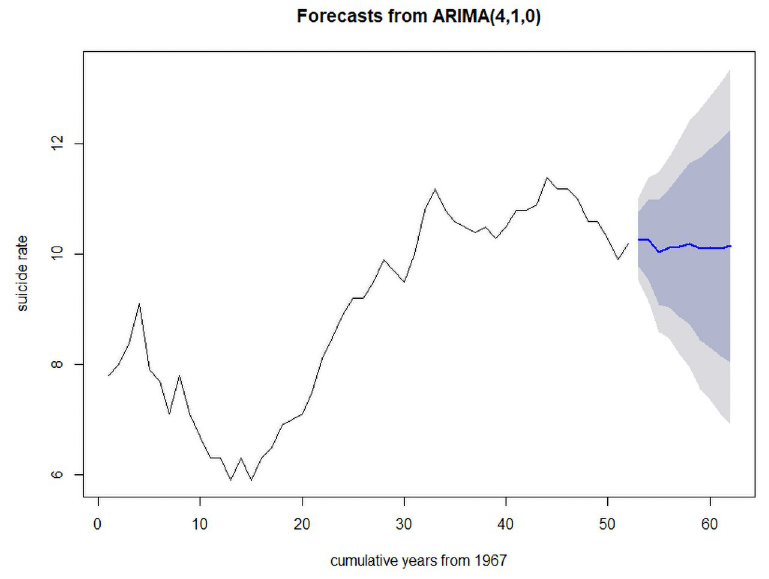
Fig 7. Forecasted plot of the suicide rate for India with 95% CI.